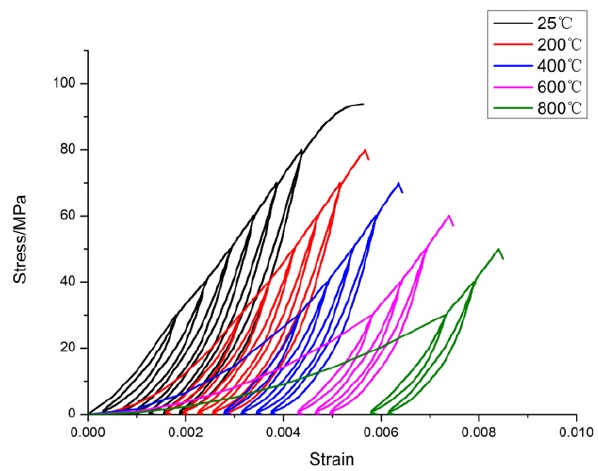
Figure 4. Stress–strain curves of sandstone after different high temperatures.